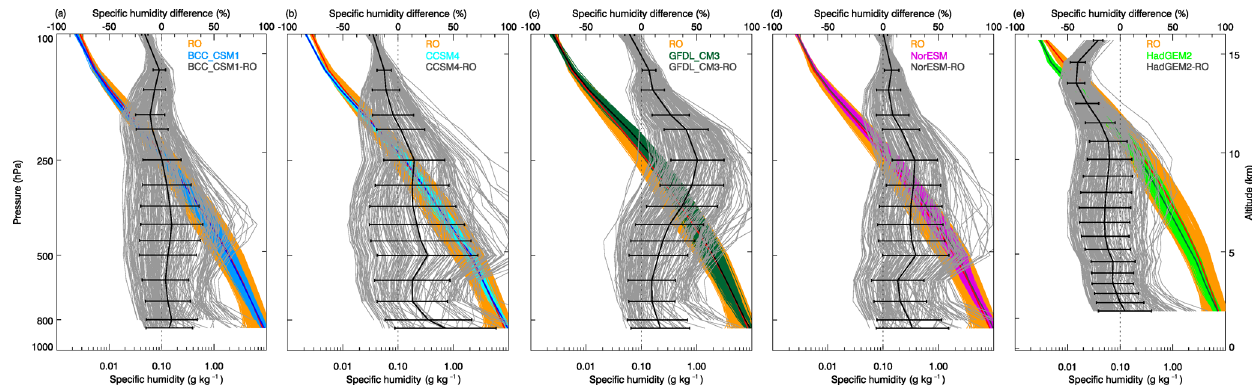
Figure 6. Specific humidity difference of model data minus RO observations (upper axes) and collocated specific humidity profiles (lower axes) for all classes ( ω 500 and T 2m ) in the tropics, shown for BCC-CSM1.1 (a) , CCSM4 (b) , GFDL-CM3 (c) , and NorESM1-M (d) at pressure levels and for HadGEM2-A (e) at corresponding altitude levels. Mean and standard deviation of the differences are indicated in black. Note the different y axis compared to Fig. 5 for